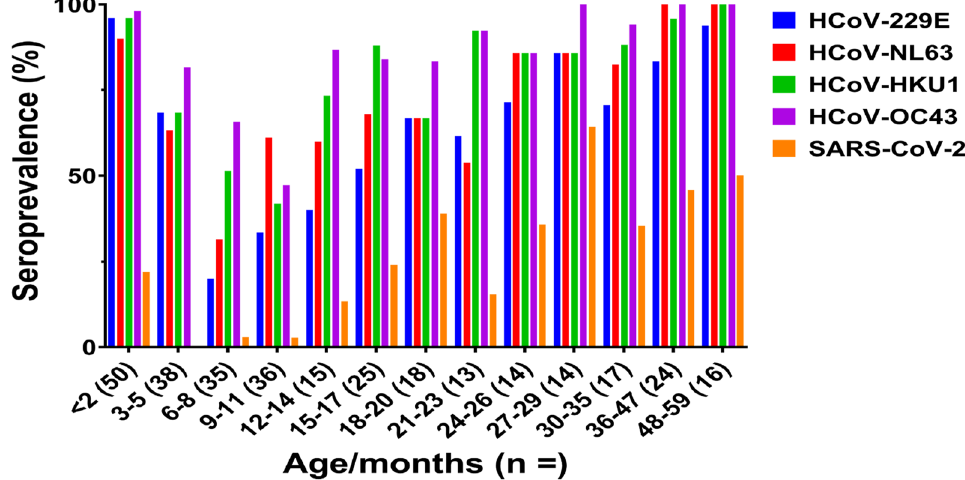
Figure 1. Seroprevalence of four endemic HCoVs and SARS-CoV-2 among different age groups of children who were collected before the COVID-19 pandemic (2015–2018) in the Philippines. The bar chart represents the percentage of serum samples that were positive for HCoV-229E (blue), HCoV-NL63 (red), HCoV-HKU1 (green), HCoV-OC43 (purple), and SARS-CoV-2 (orange) in each age group. The number of samples per age group is indicated in